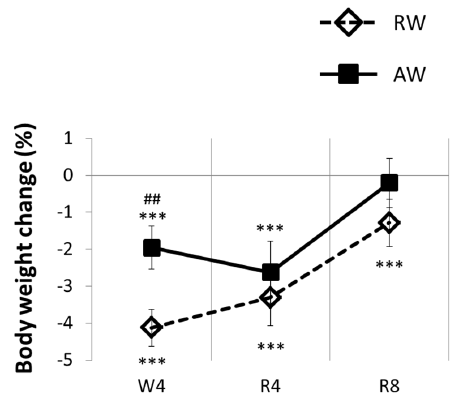
Figure 5. Body weight change during the recovery period for active workers (AW) and rest-workers (RW). Data are shown as percentage change relative to baseline. Error bars indicate SEM. W4 indicates work day. R4–8 indicates recovery days 4 and 8. *** p < 0.001, compared to baseline; ## p < 0.01, between groups.